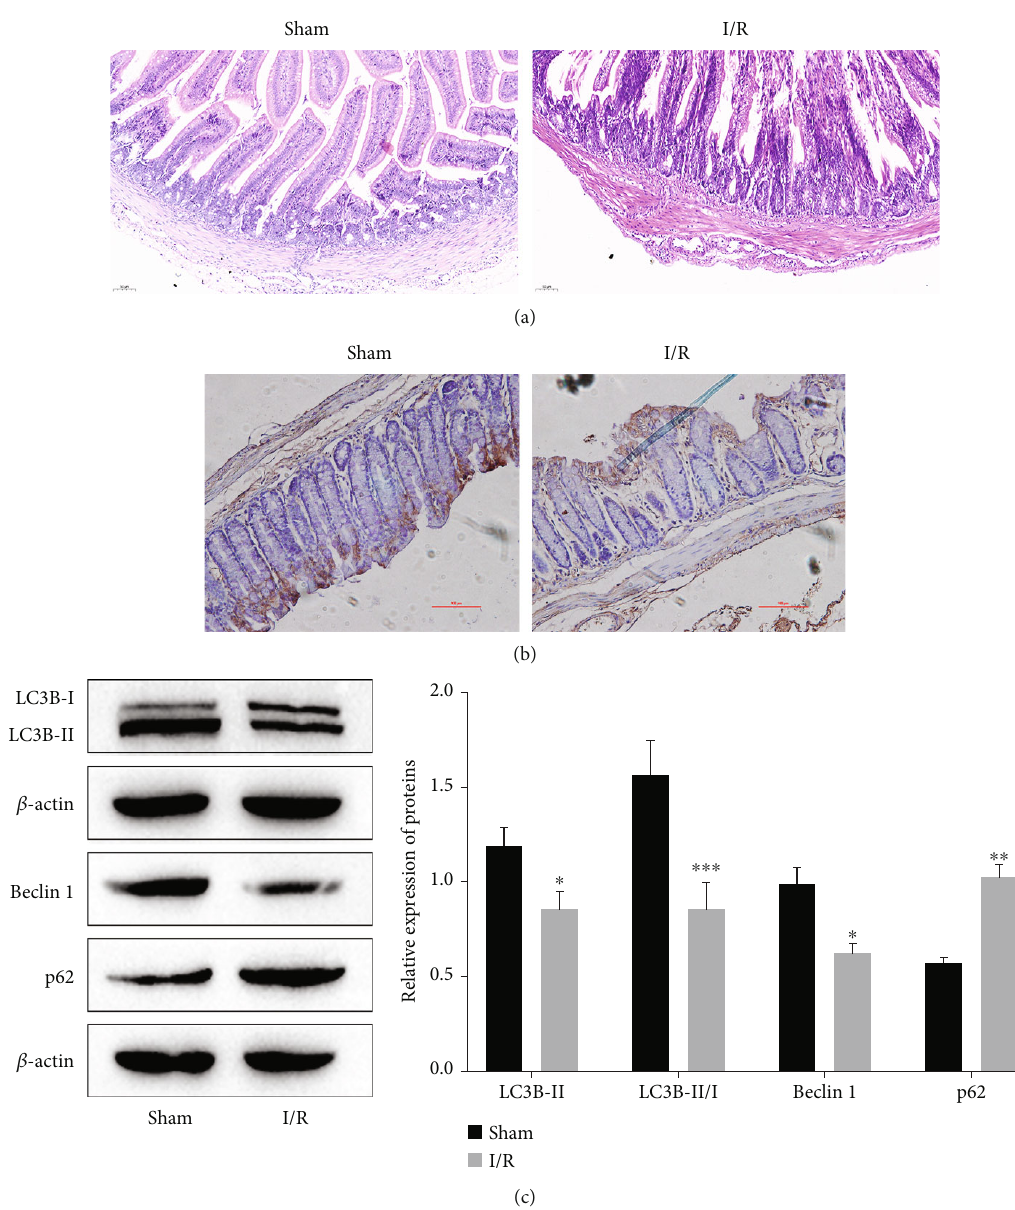
Figure 1: The change in autophagy levels after intestinal IRI. (a) Representative images of H&E staining of intestinal tissues after 2h of reperfusion. (b) The expression level of LC3B in intestinal tissues was measured by immunohistochemical staining. (c) The expression levels of proteins related to autophagy (LC3B, Beclin 1, and p62) were detected by Western blotting. ∗ P < 0 : 05 , ∗∗ P < 0 : 01 , and ∗∗∗ P < 0 : 001 vs. the sham group. n = 5 per